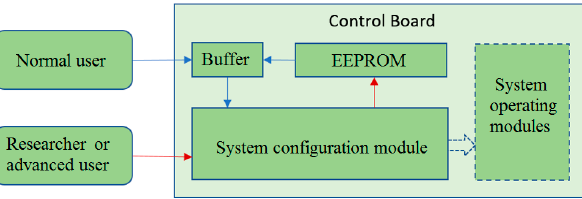
Figure 8. Entrance design for system parameter configuration.